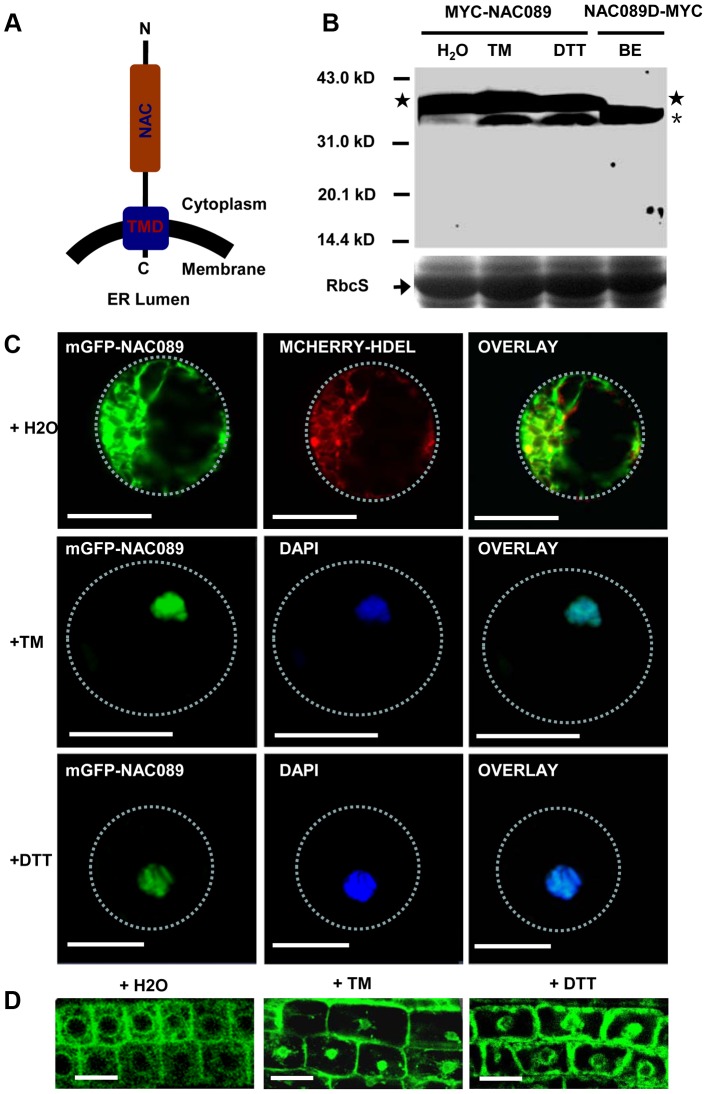
NAC089 relocates from the ER membrane to the nucleus during ER stress responses.(A) Topology of NAC089 protein. (B) Activation of MYC-NAC089 in response to ER stress. Plant seedlings were treated with H2O (control), tunicaymin (TM, 5 µg/ml) or DTT (2 mM) for 6 hr. Star and asterisk represent the precursor and the processed form, respectively. The beta-estradiol (BE) induced truncated form NAC089D-MYC was used as the migration marker. Coomassie blue staining of RbcS serves as the loading control. (C–D) Nuclear relocation of mGFP-NAC089 in response to ER stresses in Arabidopsis leaf protoplast (C) and root cells (D). TM = 5 µg/ml in C and TM = 10 µg/ml in D. Dashed lines highlight the cell boundary. Bar = 50 µm.